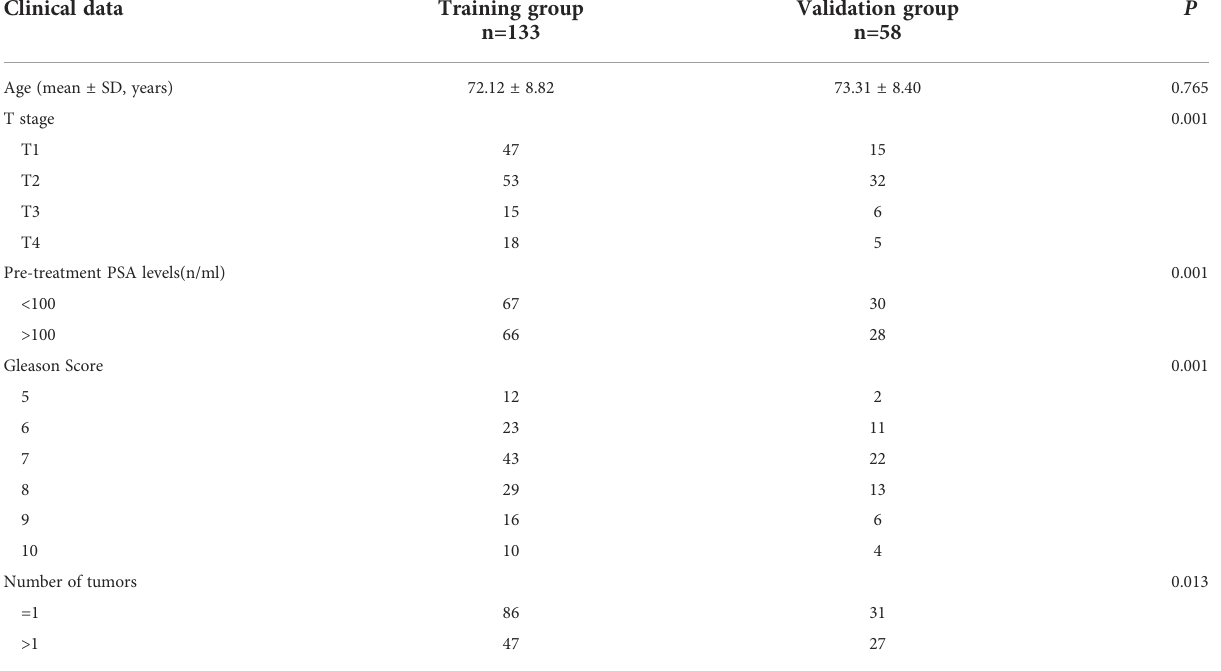
TABLE 1 Comparison of clinical characteristics between the training and validation groups. Clinical